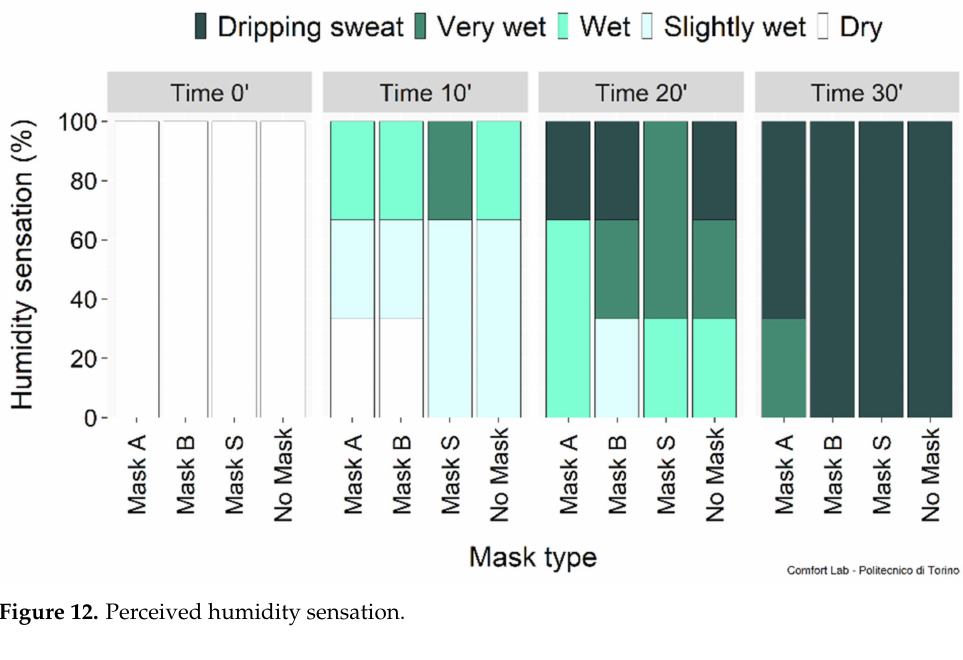
Figure 12. Perceived humidity sensation.